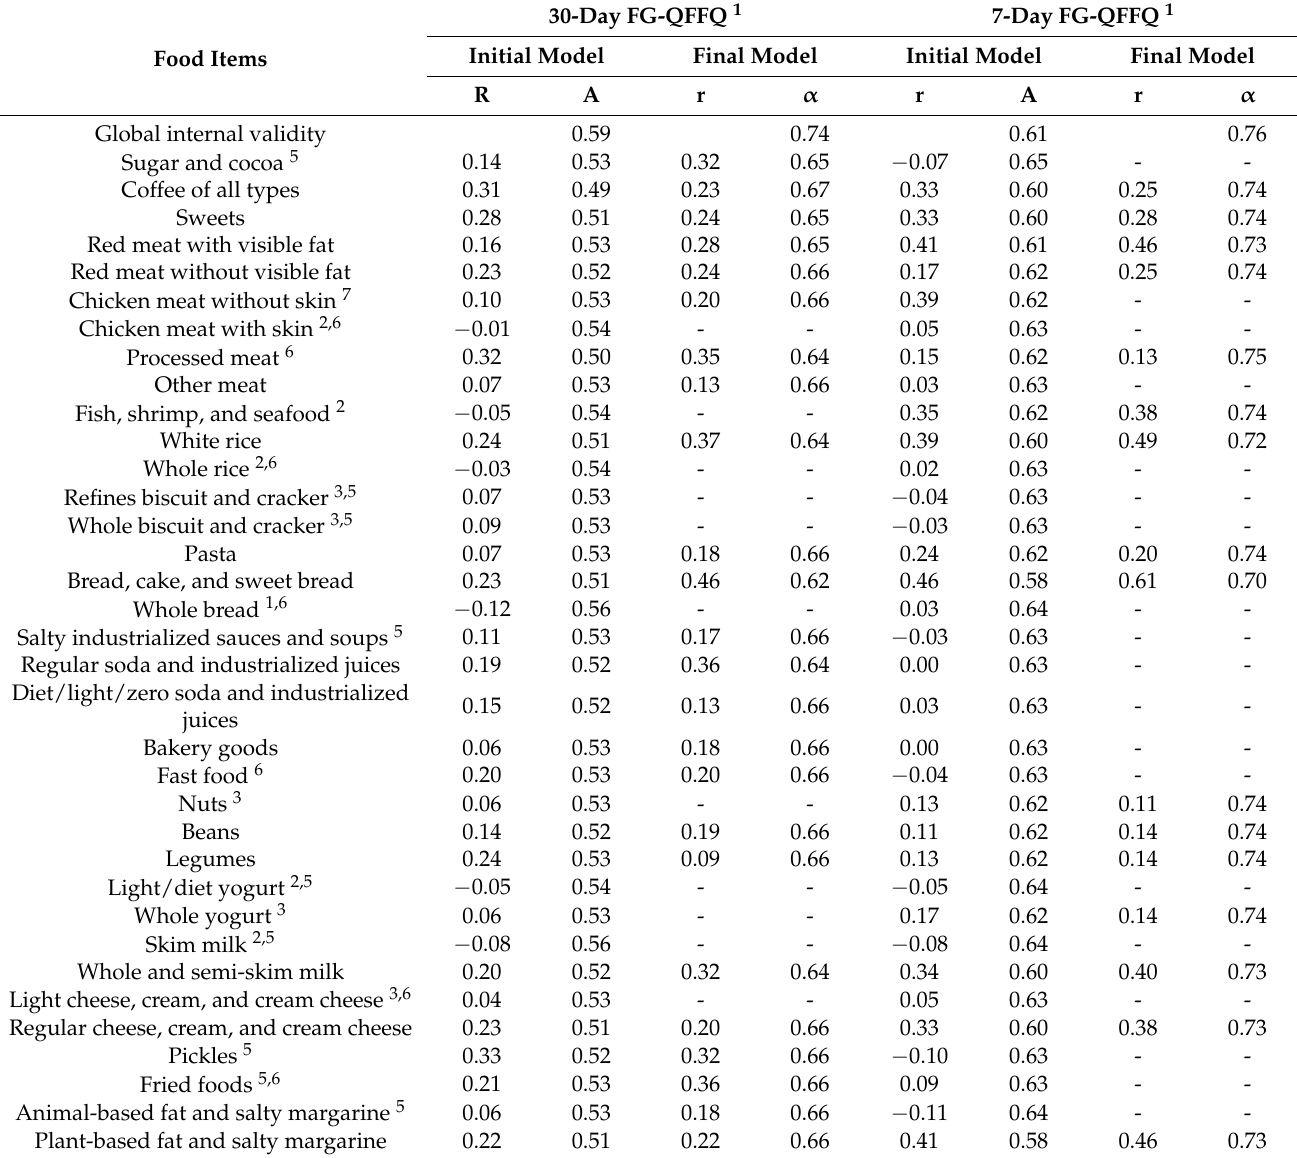
Table 5. Internal validity of the 30-day and 7-day FG-QFFQ using the intra-class confidence interval to estimate Cron- bach’s